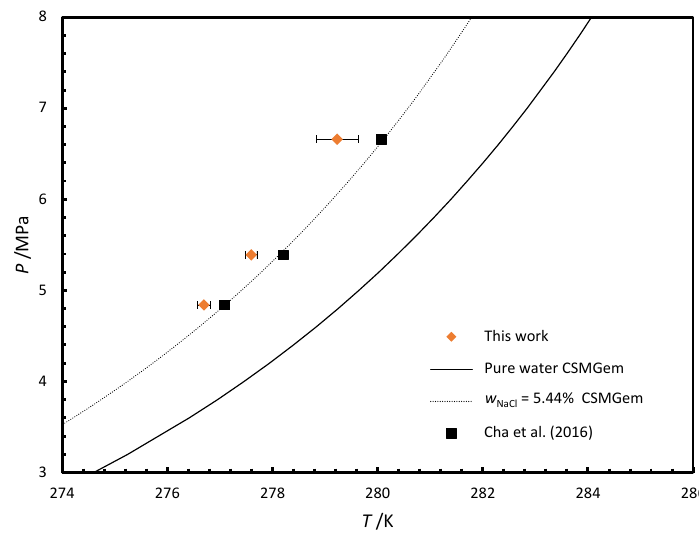
Figure 15. Hydrate-liquid-vapor equilibria for the system water + NaCl ( w NaCl = 5.44%) + CH 4 . Error bars correspond to standard uncertainty. Literature data are also shown [54]. The curves show phase equilibria predictions using CSMGem